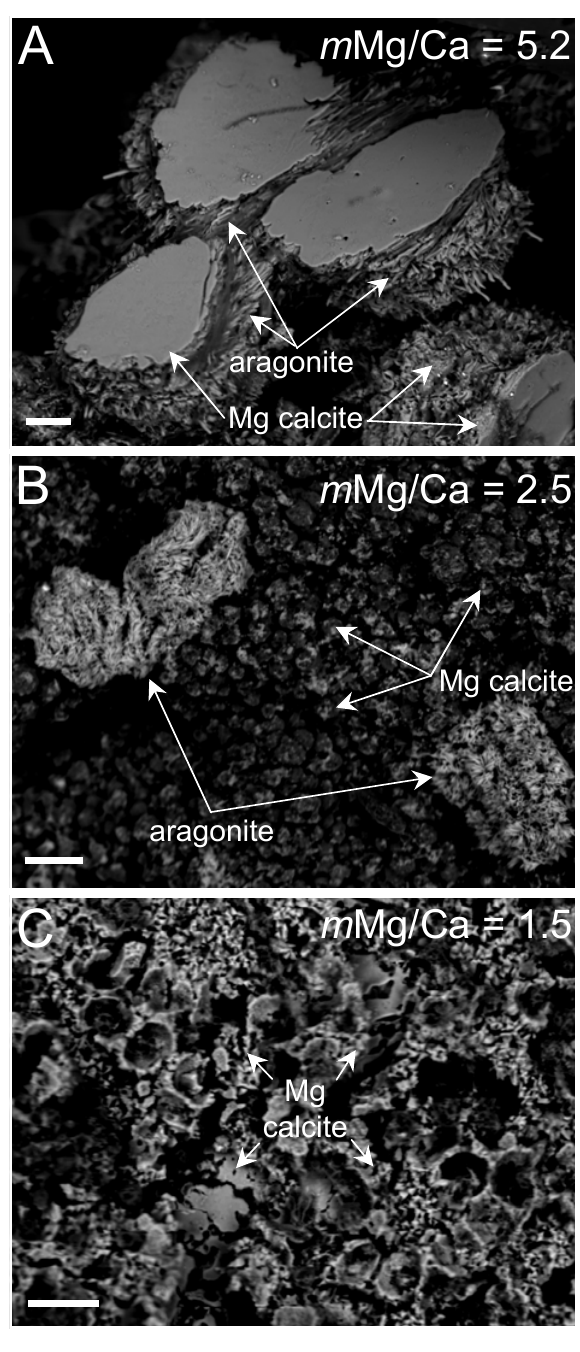
Fig. 27. Backscattered electron images showing distribution of aragonite (large, acicular crystals) and Mg calcite (small, micritic crystals) precipitates within biofilms grown in the three experimental seawaters. (A) Mg/Ca sw =5.2; 43mole-% calcite (Mg/Ca C =0.156); 57mole-% aragonite. (B) Mg/Ca sw =2.5; 86mole-% calcite (Mg/Ca C =0.078); 14mole-% aragonite. (C) Mg/Ca sw =1.5; 100mole-% calcite (Mg/Ca C =0.058). Scale bars are 20µm. Relative abundance of CaCO 3 polymorphs was determined by powder X-ray diffraction. From Ries et al. (2008).